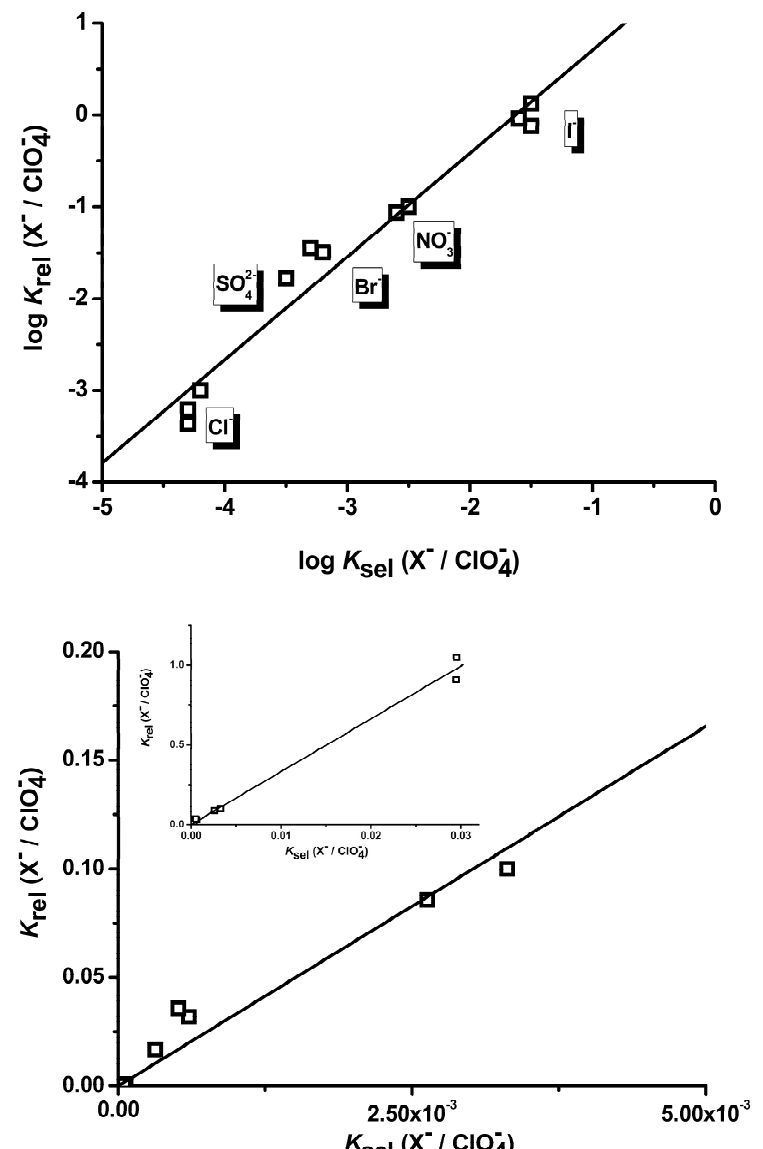
Figure 6. Linear free energy relationship (LFER) plots: log K rel (X − /ClO 4 − ) = 1.12(8) × (log K sel (X − /ClO 4 − ) + 1.8(2) ( up ); K rel (X − /ClO 4 − ) = 33.1(8) × K sel (X − /ClO 4 − ) ( down ). The experimental data of equilibrium constants for various anions were taken from literature [64].